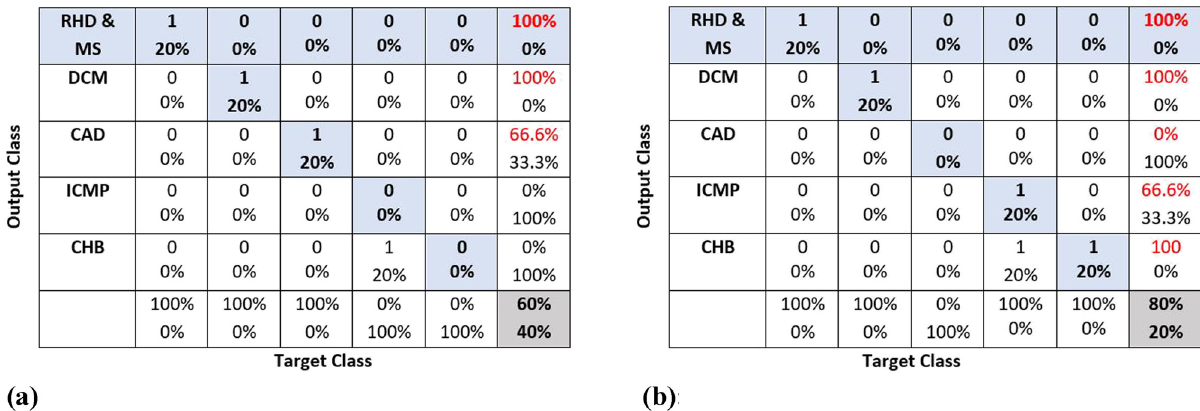
Figure 8: ( a ) Confusion matrix with 60% success. ( b ) Confusion matrix with 80%